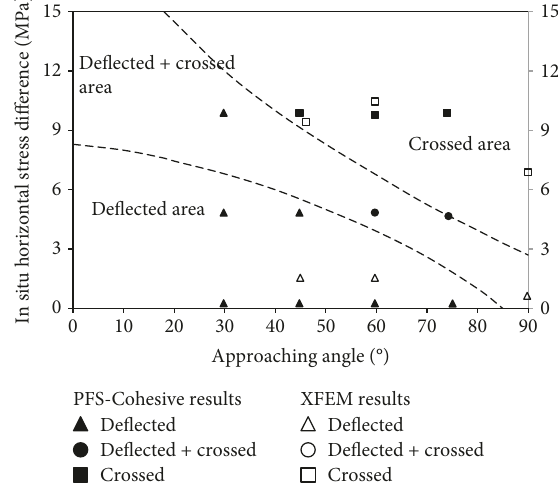
Figure 15: Result comparison between numerical simulation and physical simulation.